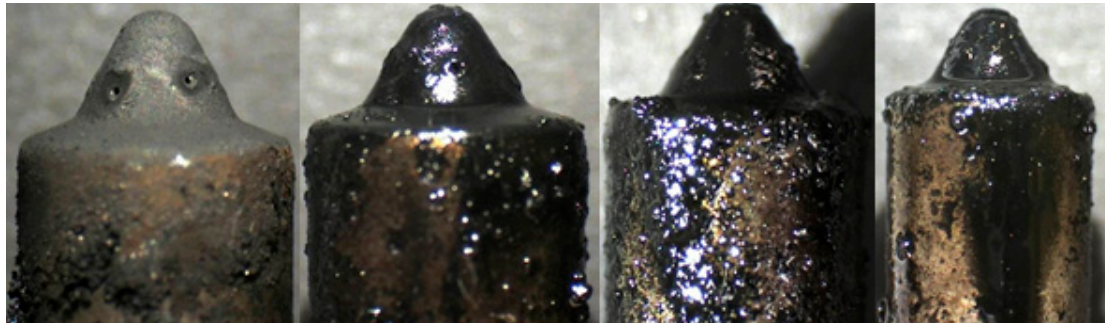
Figure 11. Common-rail injectors magnified view (10×) after 100 h operation with B70 fuel.